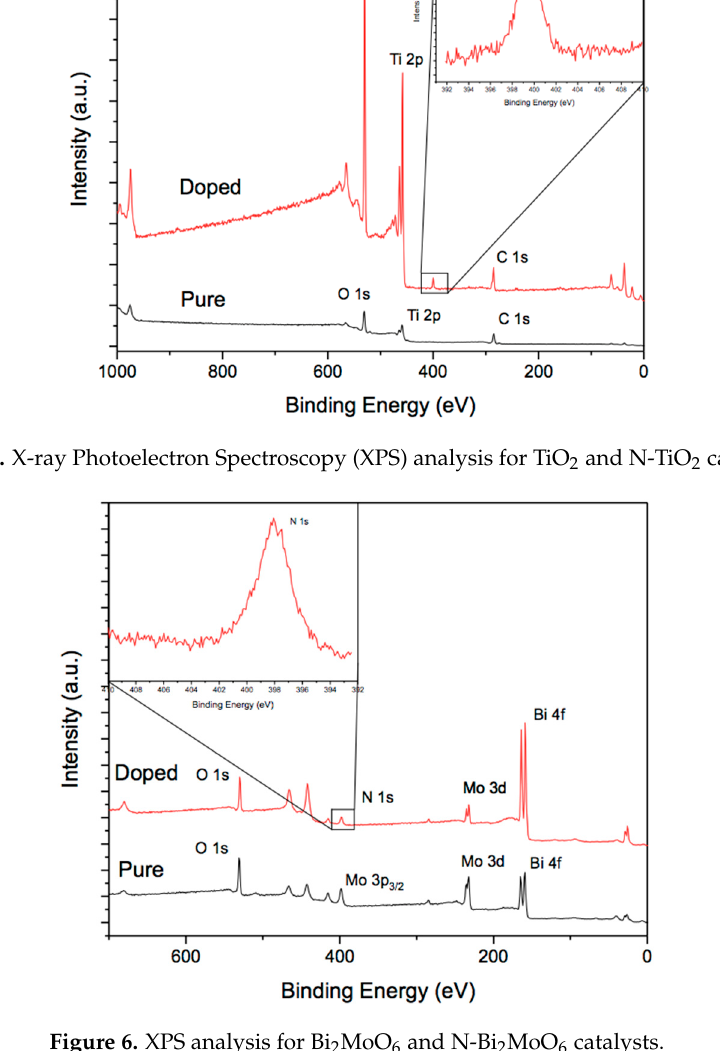
Table 3. Atomic percent values from XPS analyses for TiO 2 , Bi 2 MoO 6 , N-TiO 2 , and N-Bi 2 MoO 6 catalysts.